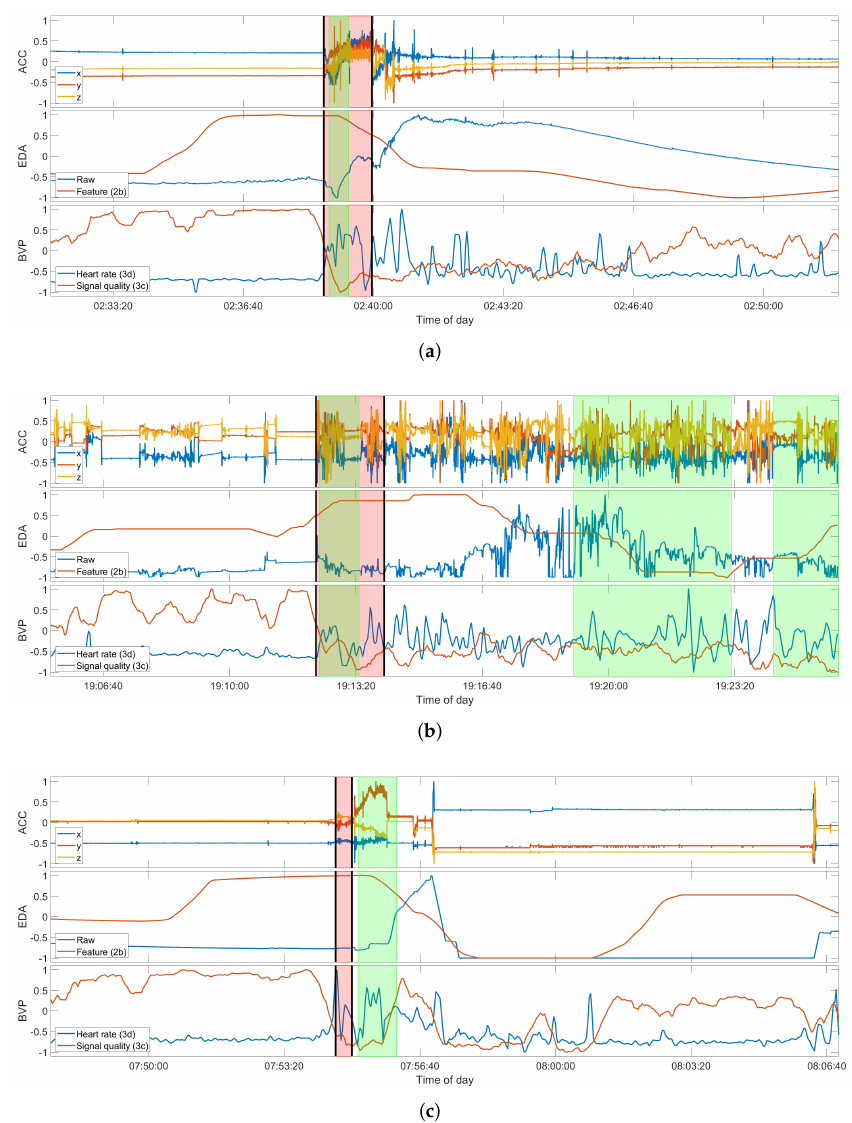
Figure 3. Selection of examples of true positive detections for each of the three participants in the intra-subject evaluation. Seizures shown are: ( a ) UKF1-4; ( b ) UKF2-3; ( c ) and KCL1-3 (see Table A1). Due to the grace period of 2 minutes around a seizure event, the detection for KCL1-3 counts as a true positive. Each plot of a seizure shows the raw ACC signal (top), the raw EDA signal and feature 2b (middle), and the estimated heart rate and signal quality index of the BVP signal (bottom). The regions highlighted in red mark the ground truth as labeled by experts, and those highlighted in green mark the seizure intervals, as predicted by the respective model, trained on the data of all the other seizures of the participant. The seizure onset and offset are additionally marked by the black vertical bars. All signals shown are normalized between − 1 to 1 only for these plots. The original value ranges before normalization can be found in Table